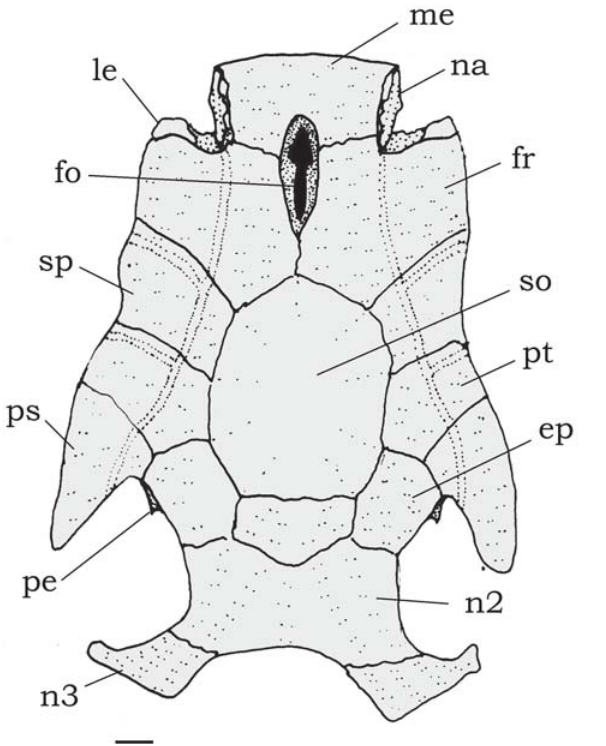
Fig. 23. Neurocranium of Tatia galaxias , RMNH 26493, paratype, 55.6 mm SL. Dorsal view. Abbreviations: ep , epioccipital; fo , single cranial fontanel, fr , frontal; le , lateral ethmoid; me , mesethmoid; na , nasal; n2 , second nuchal plate; n3 , third nuchal plate; pe , posterior epioccipital process; ps , posttemporal-supracleithrum; pt, pterotic; so , supraoccipital; sp , sphenotic. Scale bar = 1.0 mm.